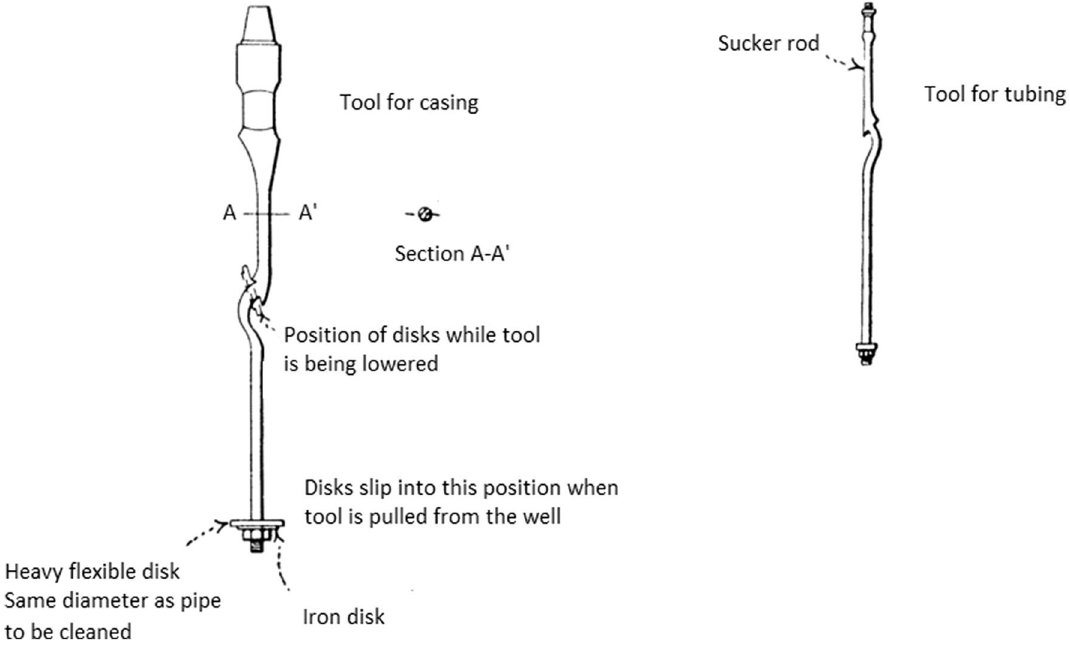
Fig. 7 Example of a wax hook tool. Adapted from (Reistle and Blade